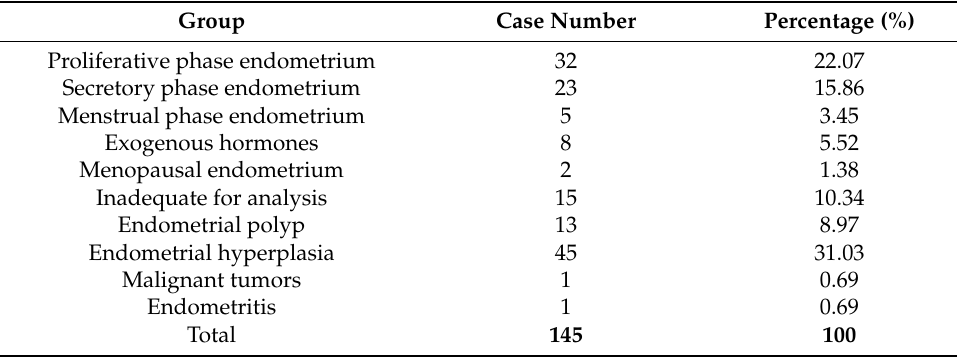
Table 9. Histopathological findings of clinically suitable samples.